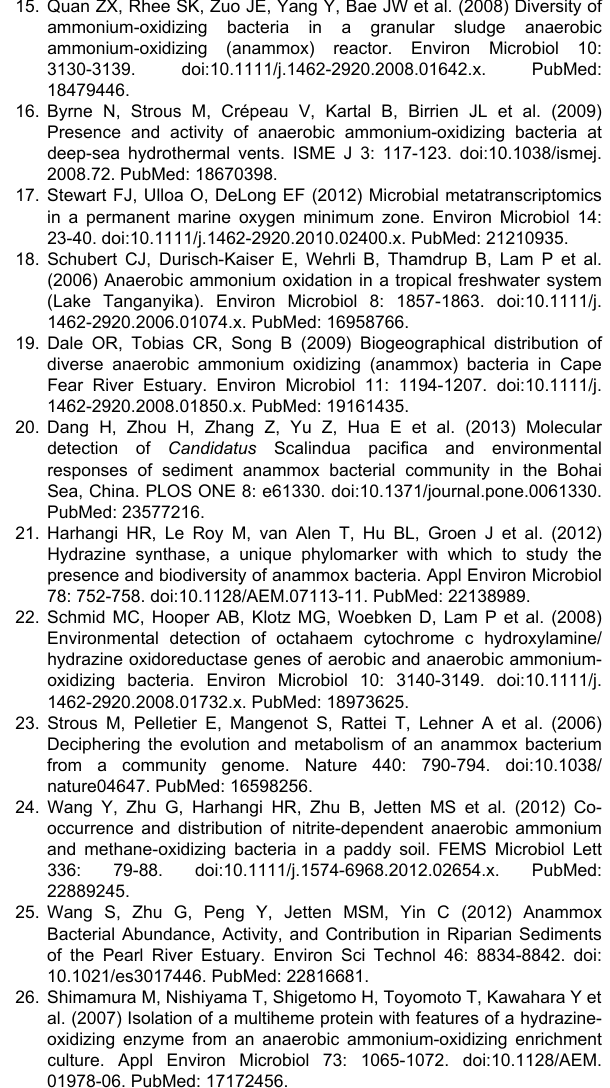
Figure S4. Spearman's rho correlation of the hzo cluster 1 and cluster 2x sequences with nitrite concentration. (DOC) Figure S5. Alignment of selected HZO cluster 1 and cluster 2x gene deduced amino acid sequences from this study and the representative HZO sequences from the